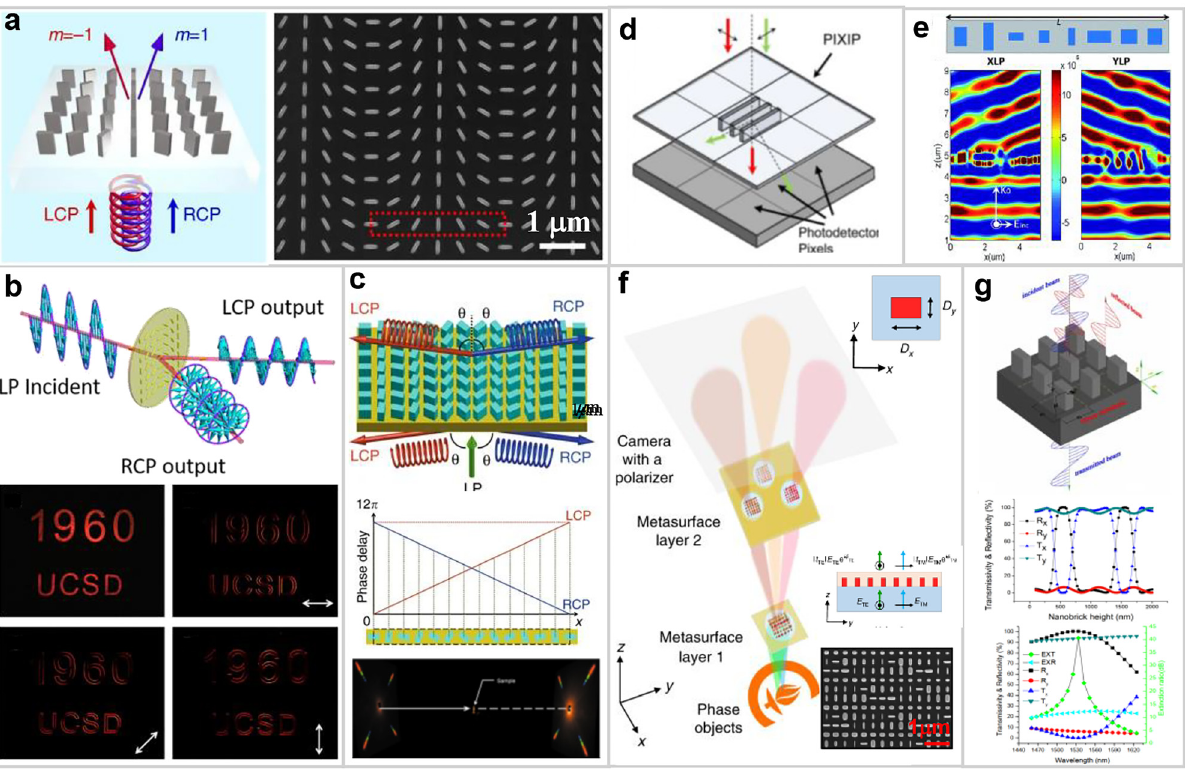
Figure4: Applicationsofpolarizationbeamsplitters(PBSs)withall-dielectricmetasurfaces.(a)Ametasurface-basedchirality-distinguishing beam splitter based on the chirality-dependent geometric phase of amorphoussilicon (a-Si) nanofin [81]. (b) A geometric phase metasurface- basedPBSforopticaledgedetection[83].(c)ASigeometricphasemetasurface-basedPBSinbothtransmissionandre fl ectionmodesforfull- spacebeamsplitting[84].(d)A linearlypolarized lightsplitterat pixellevelwithamorphous-Si nanoridges-basedmetasurface tode fl ect light polarized parallel to nanoridge length into off-axis directions while proceeds light polarized perpendicular to the nanoridge length to the center [85]. (e) Propagation phase-based PBSs supplying two distinct phase gradients for the x -linear-polarization and y -linear-polarization [86].(f)Apolarization-sensitivedielectricmetasurfacesystemforquantitativephasegradientmeasurements[89].(g)ASimetasurface-tosplit two orthogonal linear polarizations into re fl ection and transmission spaces [90]. Reprint permission obtained from [81, 83 – 86, 89,